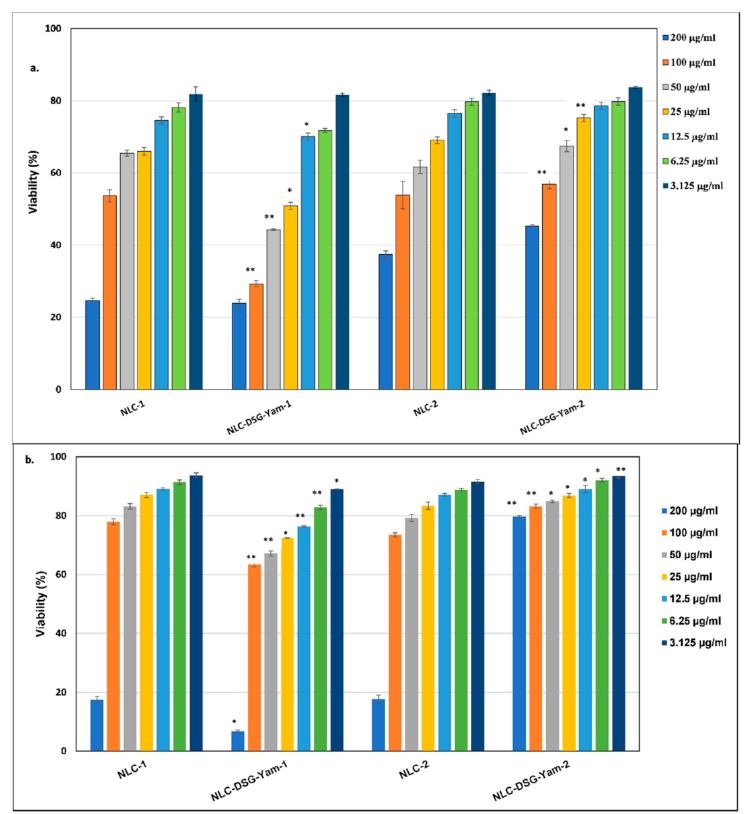
Figure 6. The effect of NLC-DSG- Yam as compared to NLC-free, on cell viability of HUVEC endothe- lial cells, after 24 h ( a ) and 48 h of treatment ( b ) * p < 0.05; ** p < 0.005; NS p > 0.05 (NS). Data are expressed as mean ± SD, n = 3 NLC-1/2 vs. other